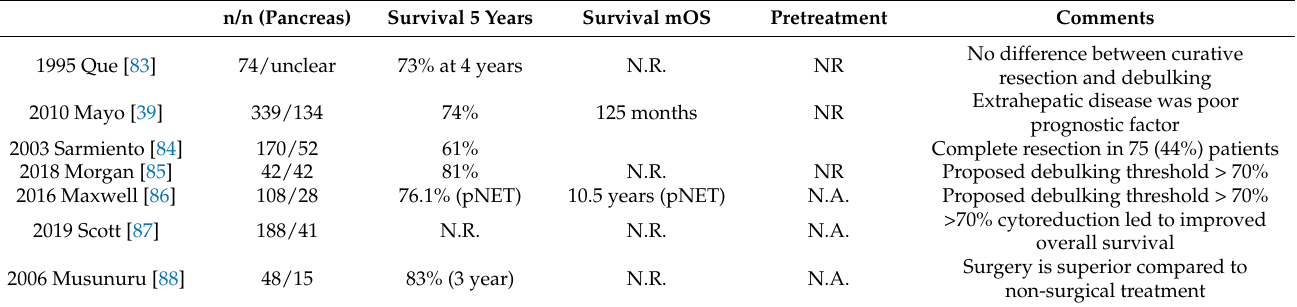
Table 4. Outcomes for two-stage hepatectomy in patients with metastatic